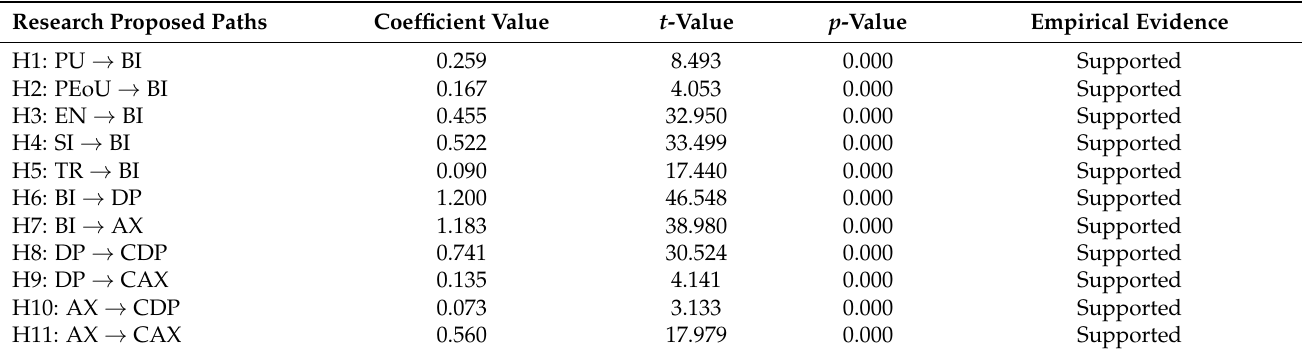
Table 6. Summary of proposed results for the theoretical model.